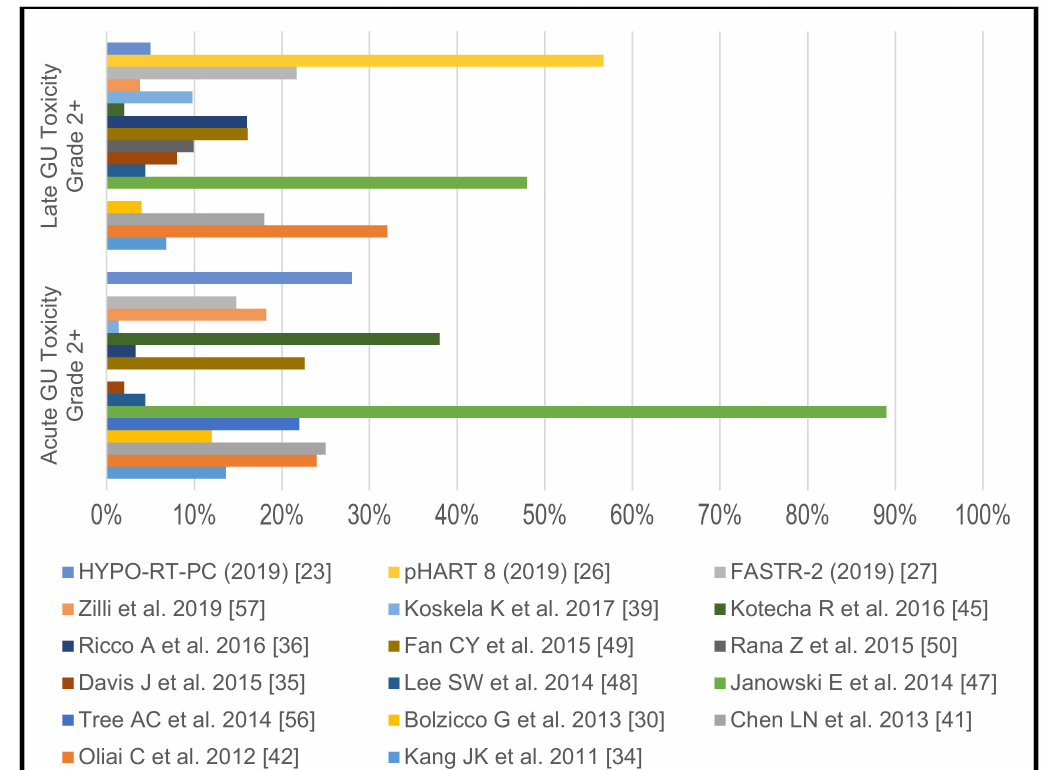
Figure 4. Acute and late genitourinary toxicity rates grades >/= 2 in studies without pelvic lymph node